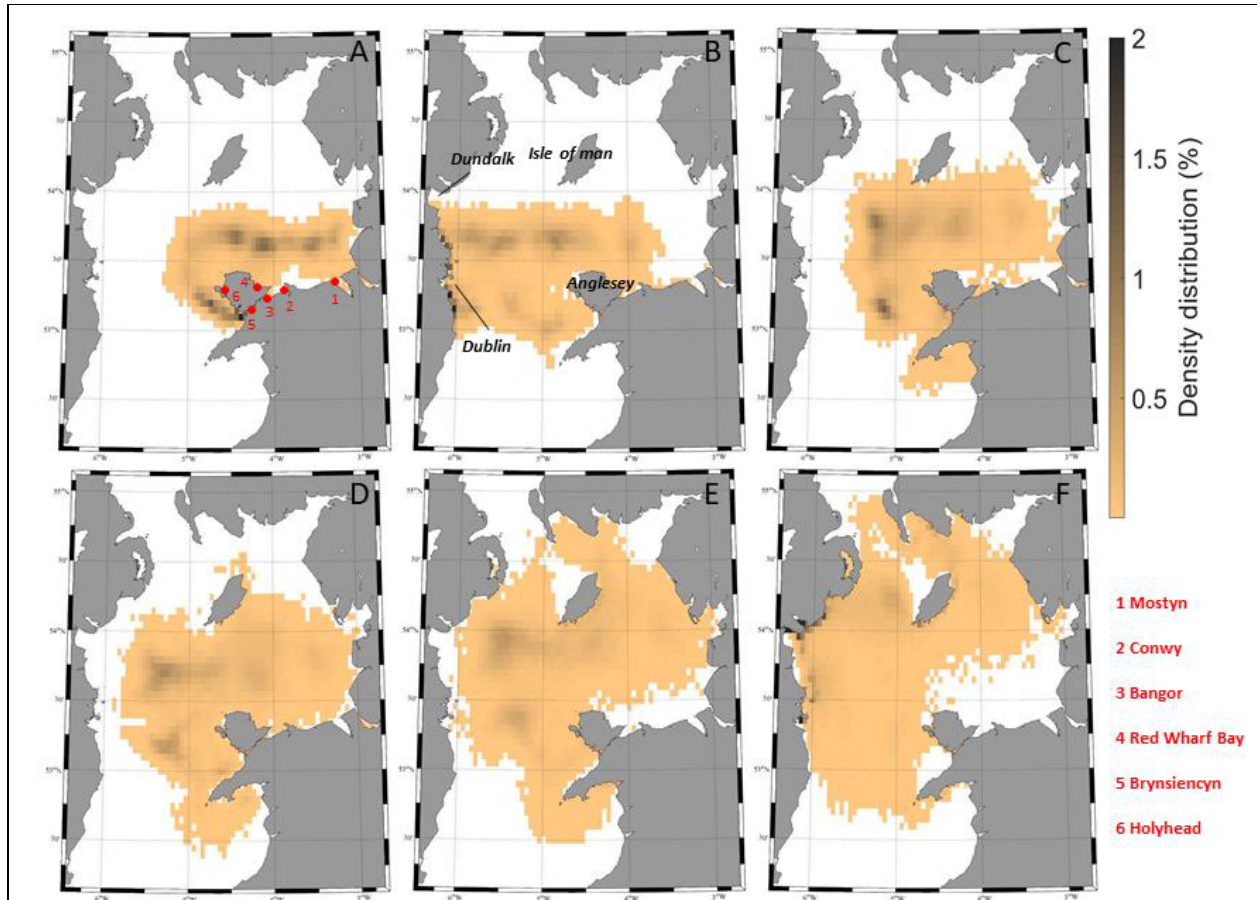
Fig. 5. Maps showing the density distribution of mussel larvae released at the surface in March-April 2018 from 6 released areas (red dots) during: (A) week 1; (B) week 2; (C) week 3; (D) week 4; (E) week 5 and (F) week